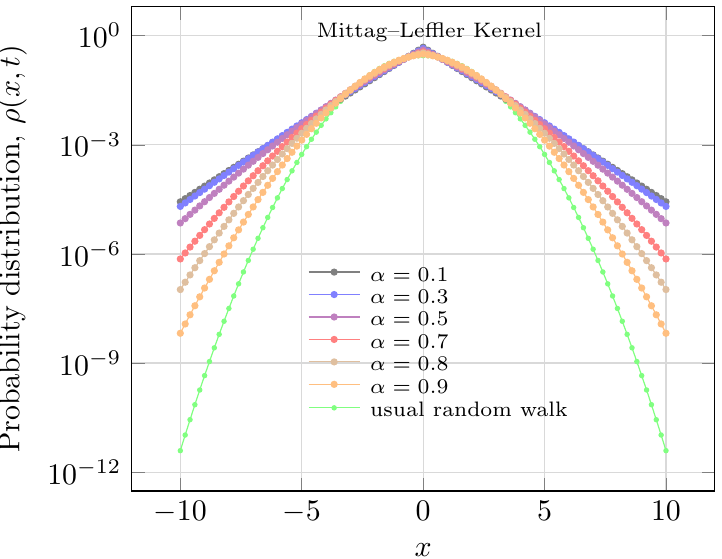
Figure 3. This curves illustrate the changes of distribution ρ ( x , t ) caused by the Mittag-Leffler kernel (Equation (4) in Equation (1)), and the usual (Brownian motion) case in Equation (4)), considering ϕ ( x ) = δ ( x ) ,